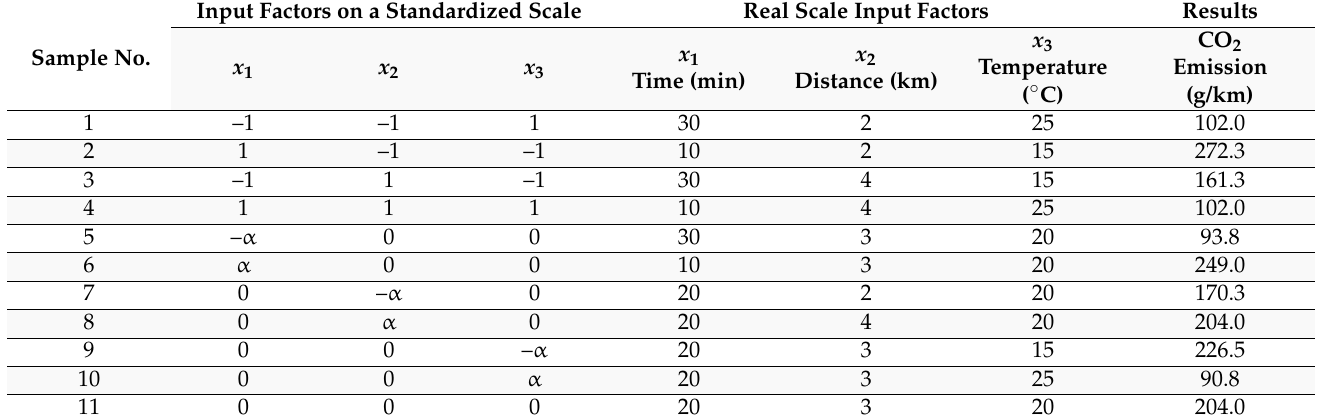
Table 3. Road test conditions and CO 2 emission values—vehicle with an